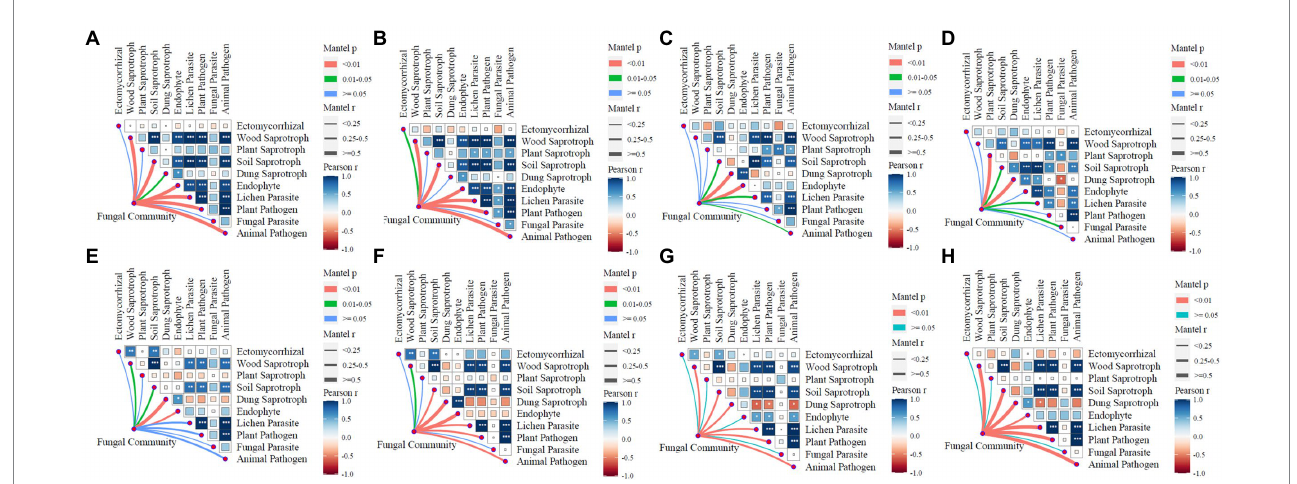
FIGURE 4 Relationships between fungal network communities and functions for each treatment in two soils. (A–D) are control, L, M, and H treatments in JSJ soil, respectively; and (E–H) are control, L, M, and H treatments in LF soil,